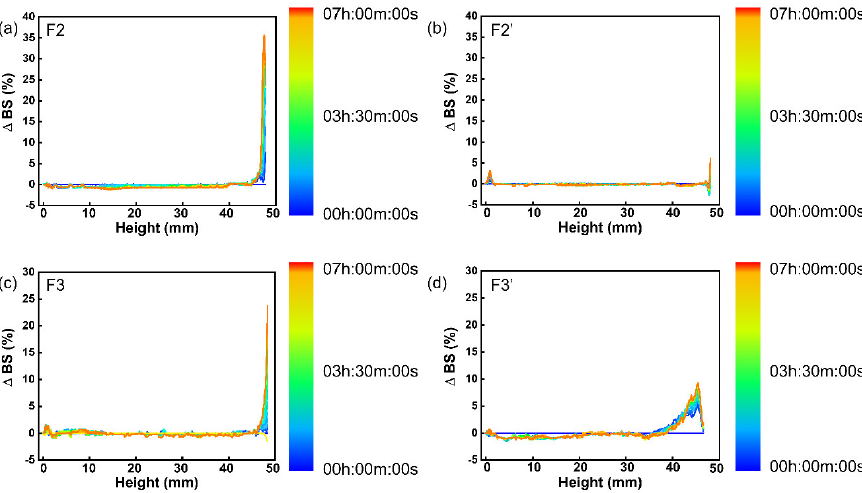
Figure 7. Turbiscan profiles of backscattering for ( a ) F2, ( b ) F2′, ( c ) F3, and ( d ) F3′, over 7 h.